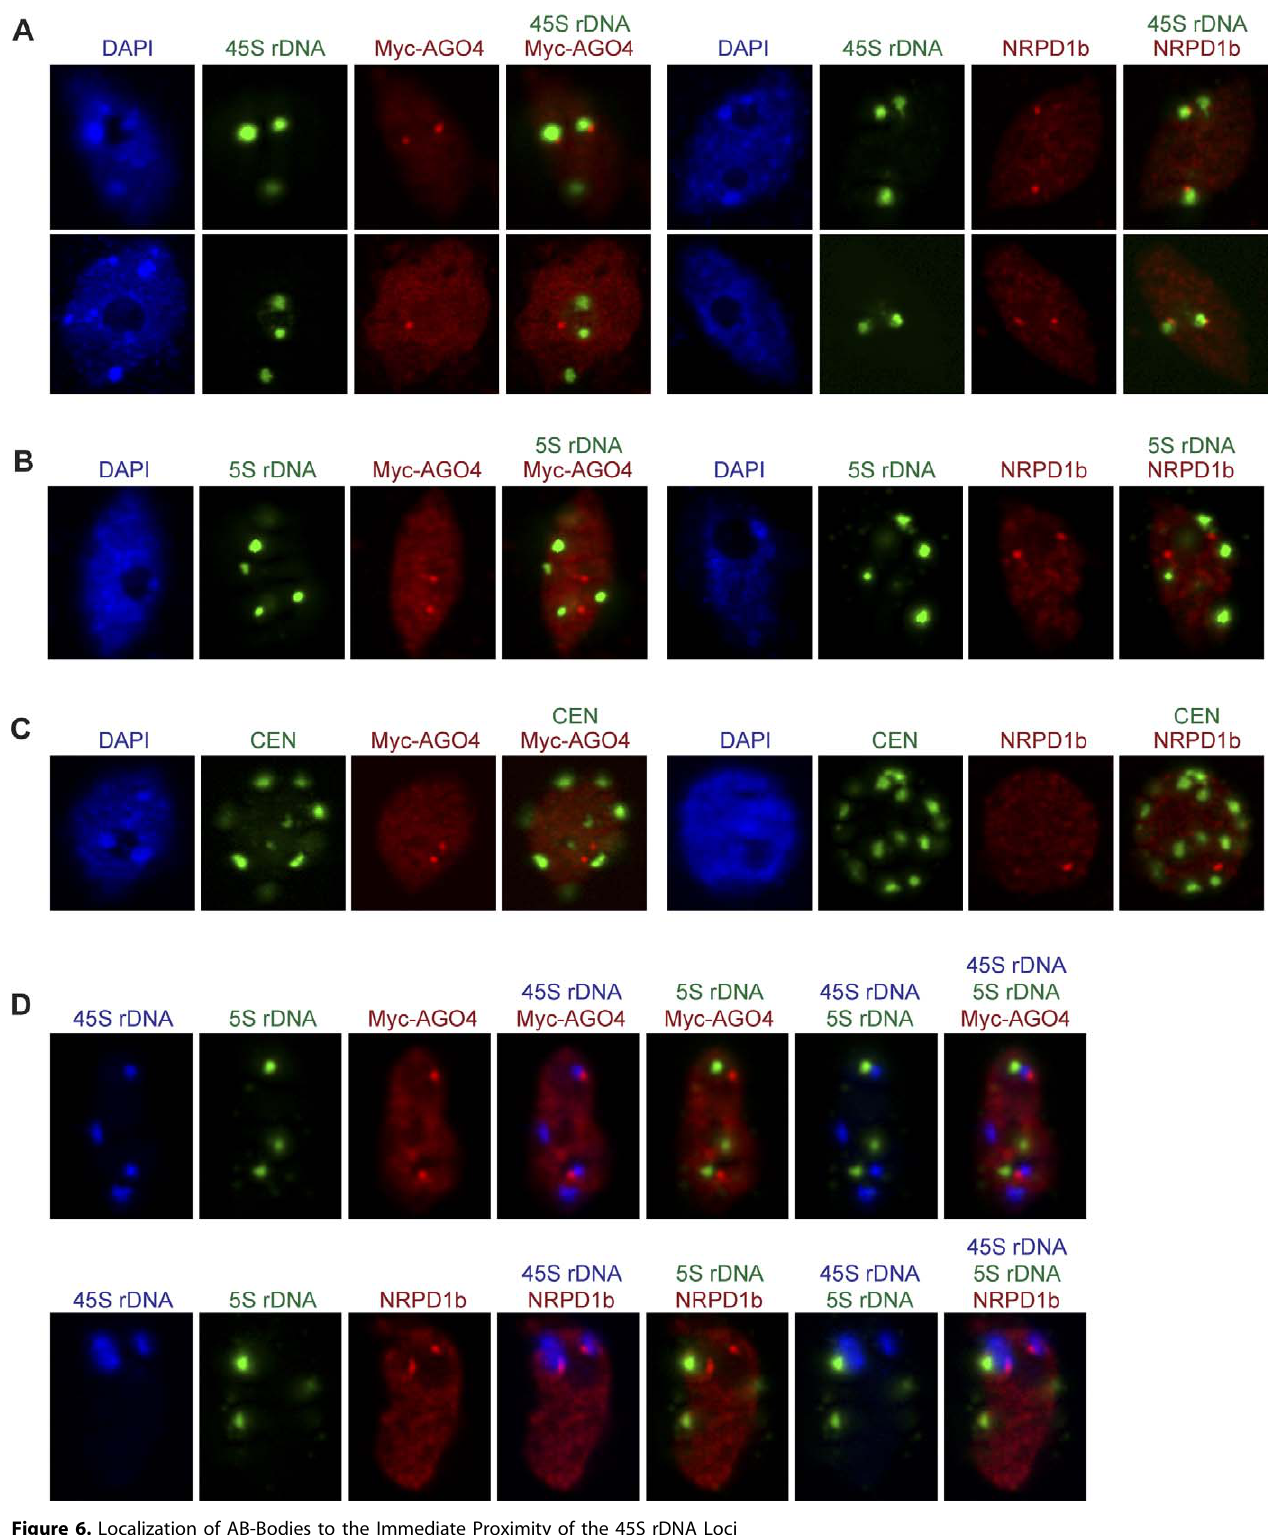
Figure 6. Localization of AB-Bodies to the Immediate Proximity of the 45S rDNA Loci (A) DNA FISH analysis of the condensed 45S rDNA loci (NORs) relative to Myc-AGO4 (left) or NRPD1b (right) localization in Myc-AGO4 or Ler nuclei, respectively. (B,C) Localization of AGO4 or NRPD1b is shown relative to (B) 5S rDNA loci or (C) centromeric repeats ( CEN ). (D) Dual probe DNA FISH analysis showing 45S and 5S rDNA loci relative to Myc-AGO4 (top panel) or NRPD1b (bottom panel). The 45S probe was labeled with biotin and the 5S probe was labeled with digoxigenin (DIG). NOR4 is observed as a 45S rDNA signal with an adjacent 5S rDNA signal, while NOR2 shows only 45S rDNA signal with no adjacent 5S rDNA